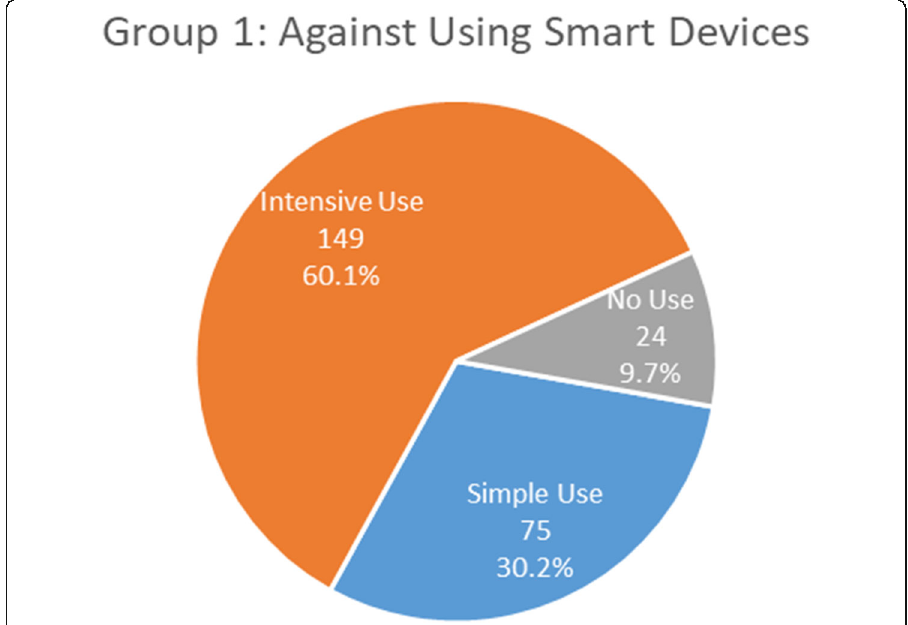
Fig. 4 Classification of instructors against the use of smart